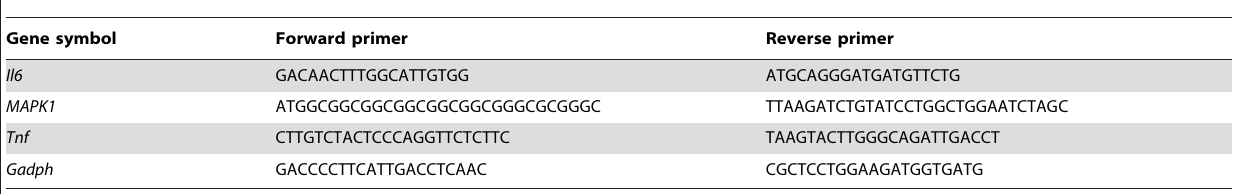
Table 1. Olgonucleotide sequences for mRNA Q-PCR.